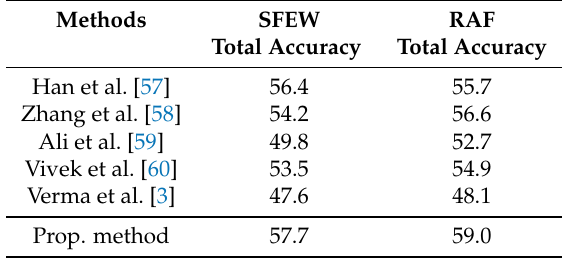
Table 3. Total accuracies are presented for the reference methods and our proposed method considering both datasets, namely SFEW and